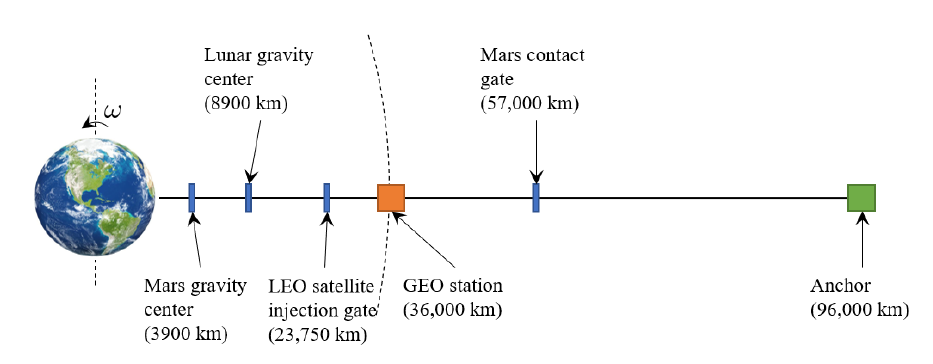
Figure 3. Specific position function of segmented space elevator system model.